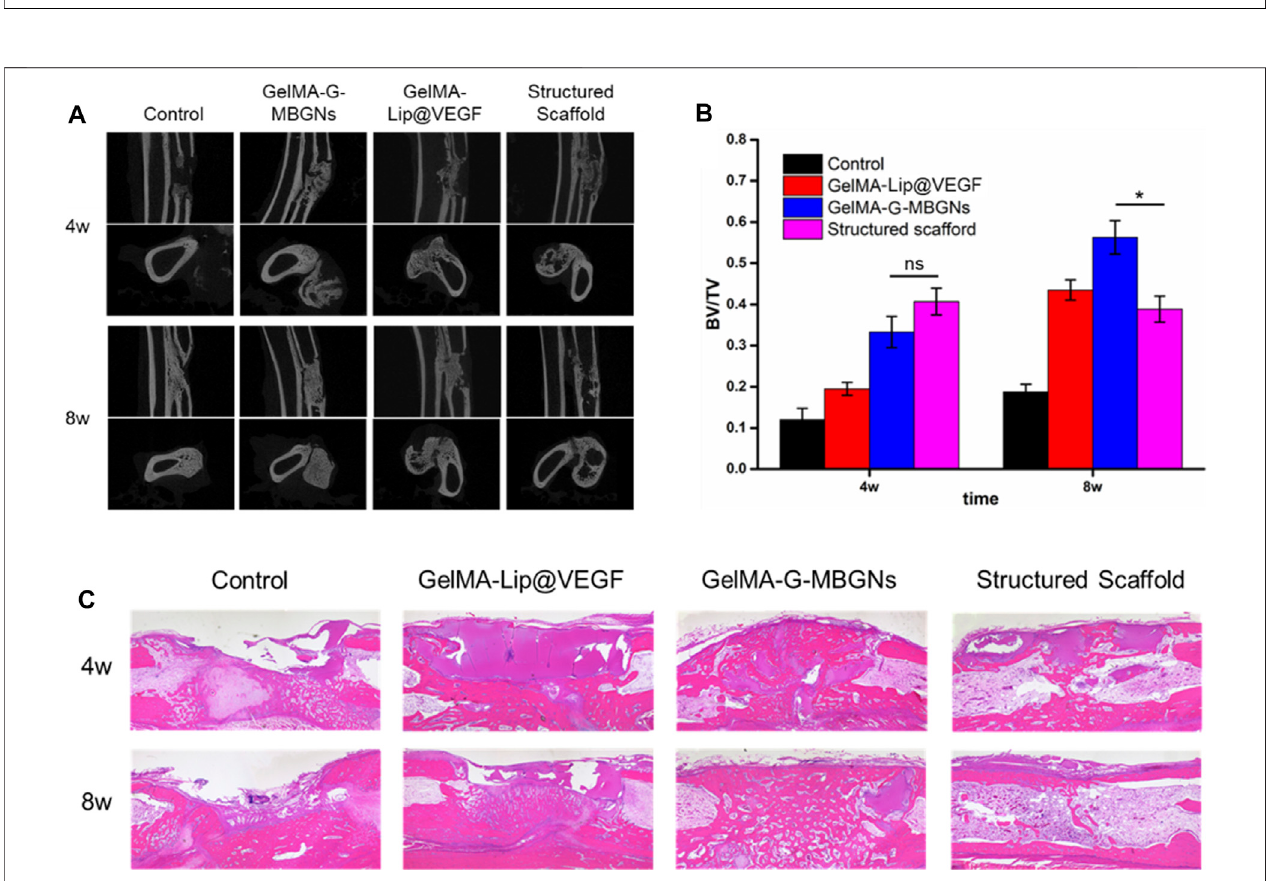
FIGURE 11 | Radiological and pathological assessment of the animal model. (A) Micro-CT observation of the bone defect. (B) Quanti fi ed BV/TV analysis. (C) H&E staining of the samples.